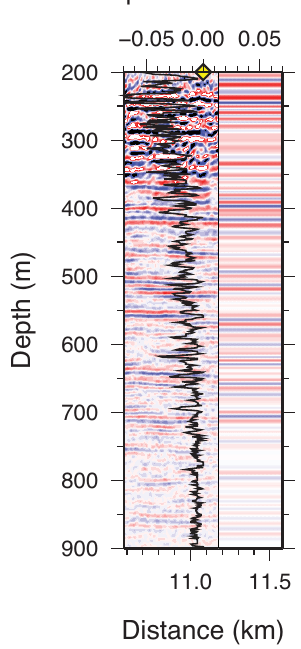
Fig. 4. Temperature gradient plotted on top of a portion of the mi- grated image of swath S170 (see Fig. 3) and a synthetic section. The synthetic section was calculated by convolving an average source wavelet with the reflection coefficient profile. Yellow diamond at the top indicates location of the XBT cast near shotpoint 3616, from which the reflection coefficient and temperature gradient have been